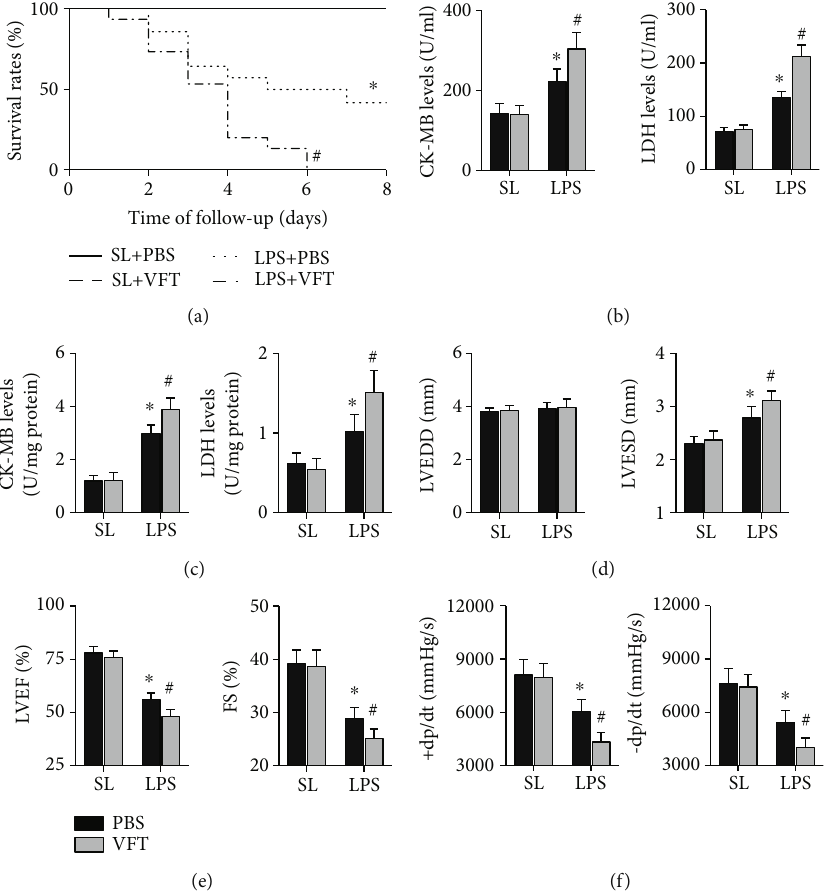
Figure 2: E ff ects of visfatin on LPS-induced cardiac injury in mice. (a) The survival rates in the four groups were analyzed during follow up; N = 10 − 15 in each group. (b and c) The expression levels of CK-MB and LDH in both the serum and heart were examined. (d – f) LVEDD, LVESD, LVEF, FS, +dp/dt max, and − dp/dt max in each group were detected. N = 5 − 10 in each group. ∗ p < 0 : 05 vs. the saline +PBS group. # p < 0 : 05 vs. the LPS +PBS group. SL means saline; VFT means